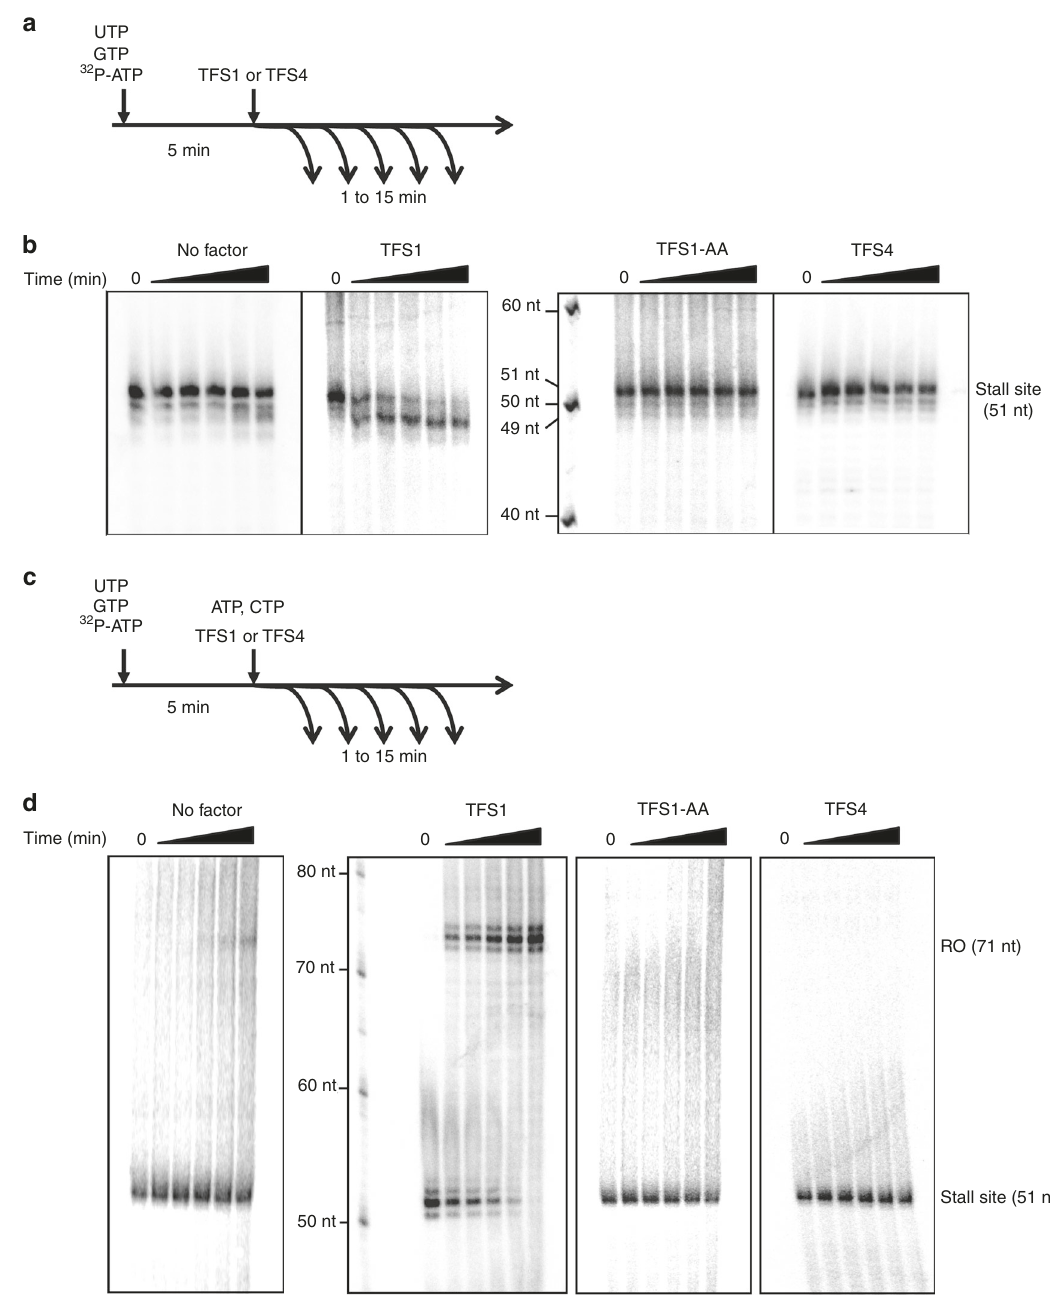
Fig. 2 TFS1 but not TFS4 stimulates RNAP transcript cleavage activity. a Outline of transcript cleavage assays. The reactions containing A*/G/UTP mix and the SSV1-T6 promoter fused to a 50 nt C-less cassette were incubated at 75 °C. After 5 min, TFS1 or TFS4 was added to the reaction. Samples were collected at various time intervals (0, 1, 2, 5, 10 and 15 min). b Denaturating PAGE analysis of transcript cleavage products in the presence or absence of TFS1, TFS1-AA or TFS4. c Outline of reactivation assays. The reactions were performed with A*/G/UTP mix using SSV1-T6 promoter fused to 50 nt C-less cassette. After 5 min at 75 °C, TFS1 or TFS4 was added and the reaction was chased with CTP and an excess of ATP. Samples were collected at various time intervals (0, 1, 2, 5, 10 and 15 min). d Denaturating PAGE analysis of reactivation products in the presence or absence of TFS1, TFS1-AA or